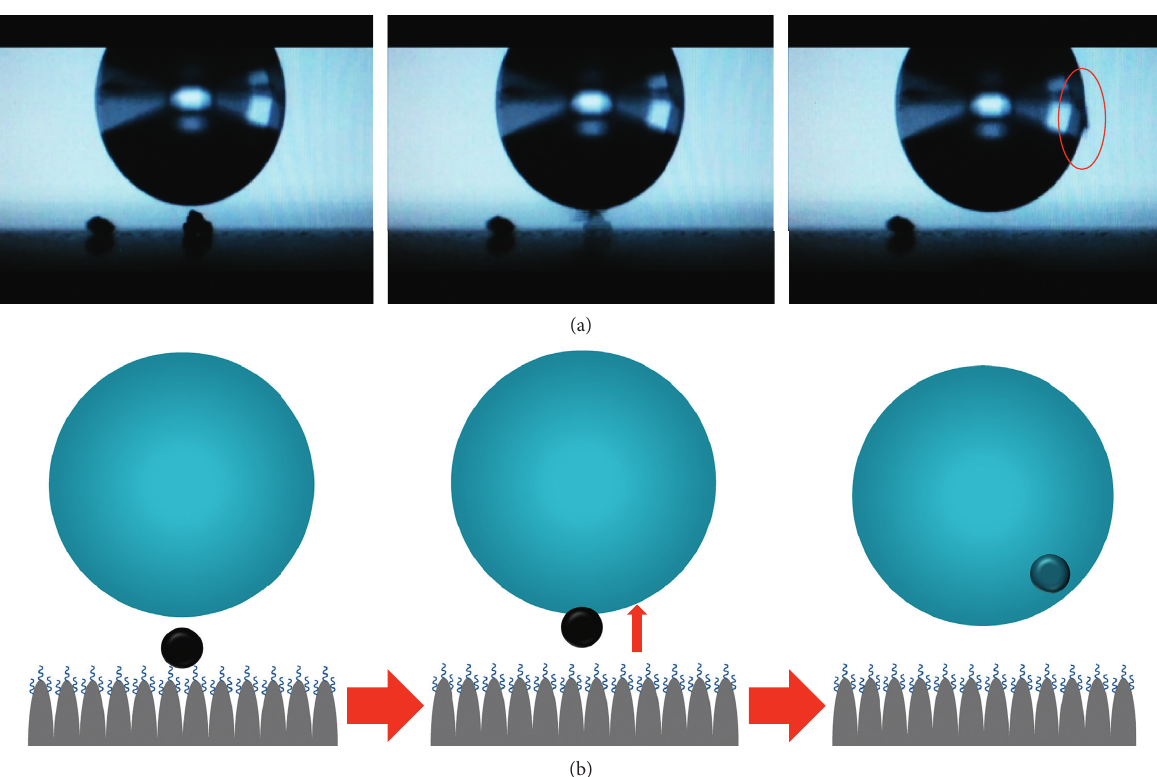
Figure 11: “Absorbing” cleaning mode: (a) photos taken by using a camera and (b) schematic of the “absorbing” particle removing